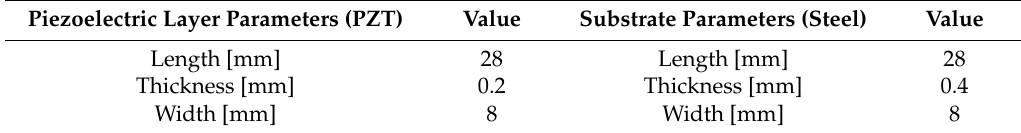
Table 1. Structural parameters and material properties of PE element in the analysis.